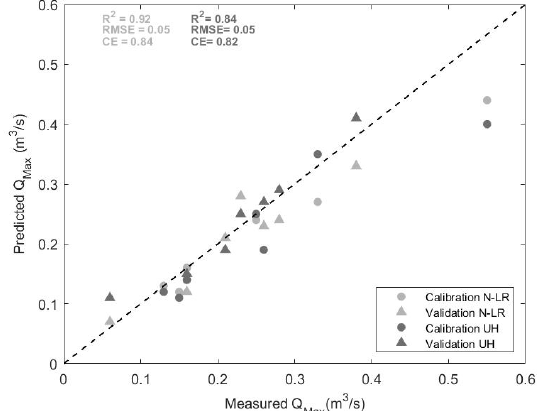
Figure 7. Comparison plot between measured and predicted peak flow Q Max , for N-LR (light grey) and UH (dark grey) model in either calibration (solid circle) or validation (solid triangle) step.